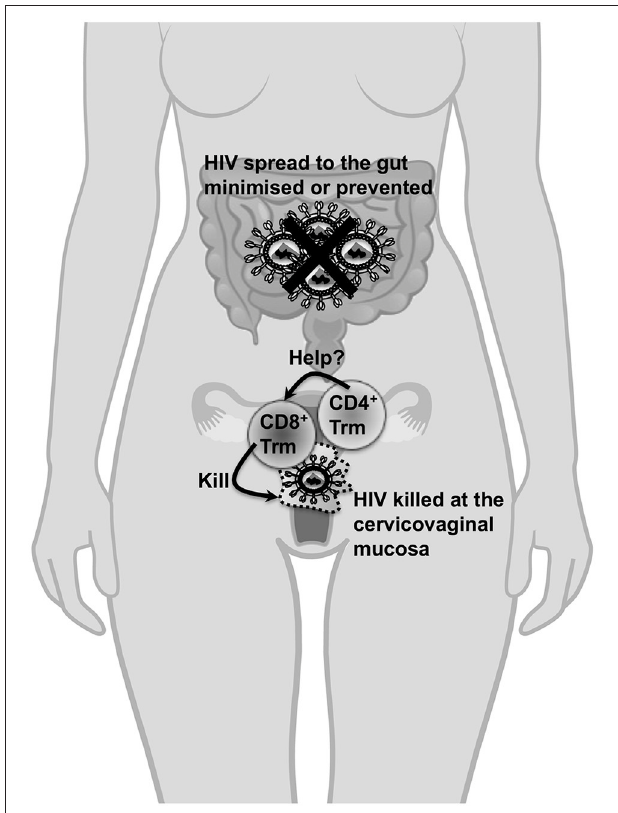
FIGURE 1 | The importance of cervicovaginal Trm cells in protection against HIV-1. Cervicovaginal Trm cells will migrate through the cervicovaginal tissues for the lifespan of an individual and do not need to be recruited to the cervix or the vagina unlike other memory T cell subsets (which could take days to be recruited to these sites following primary exposure) during HIV-1 exposure. Thus, the presence of CD8 + Trm cells in cervicovaginal tissues is crucial to kill transmitted cell-associated forms of HIV and nascent infected cells resulting from cell-free virus during transmission. Most importantly, the transmitter/founder virus which initiates the HIV infection will likely be most vulnerable for destruction when CD8 + Trm cells are present at the cervicovaginal mucosa during primary exposure. Consequently, the likelihood of the virus spreading systemically, especially to the gut where a vast majority of CD4 + T cells are depleted during acute infection, is minimized or prevented. Furthermore, the presence of these Trm cells in this instance is also expected to significantly reduce the viral set point to an extent that it is unlikely for the infected individual to transmit the virus. It is unclear whether CD4 + Trm cells form in the cervicovaginal mucosa, whether they can act as targets for HIV infection or whether they will provide essential help to CD8 + Trm cells. The protective role of CD8 + Trm cells will likely apply to scenarios where HIV-1 is exposed in the rectum although there are no studies to demonstrate how these cells can be elicited in this